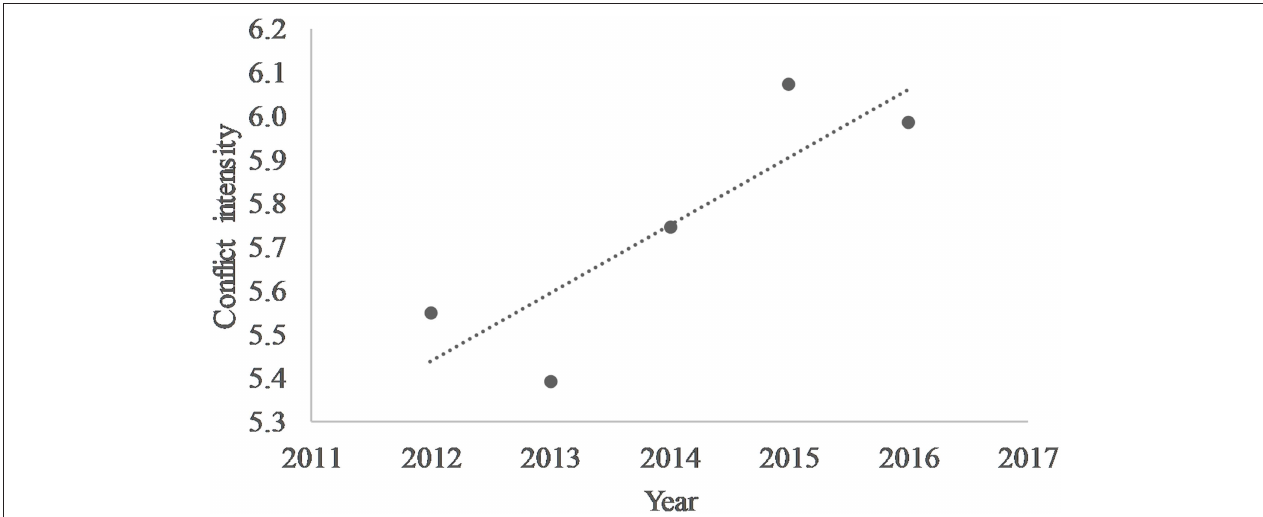
FIGURE 6 | Trend in the intensity of livestock predation ( number of predation events/number of villages with predation ) by lions in between 2012–2016 within the Saurashtra landscape. The data on livestock kill by lions encompasses a total of 914 villages across the entire range of Asiatic